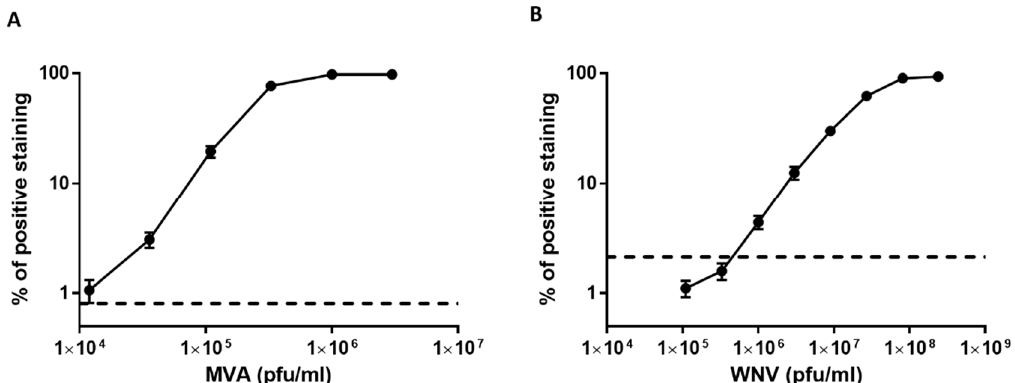
Figure 4. Dose response analysis of MVA and West Nile Virus after capture by Vero cells. ( A , B ) The cells were harvested and diluted to achieve 20,000 cells per tube. WNV and MVA (diluted in 2% FBS-MEM) were added at the indicated concentrations for one hour with shaking at 4 ◦ C to allow attachment. The cells were then immuno-labeled with a relevant fluorescent antibody and analyzed by FACS. Dashed black line represents the limit of detection of the assay (2.12% of positive staining for WNV and 0.8% for MVA) which was determined by 3 times the mean value of background noise from non-infected cells. The results shown represent average values ± SEM from 3 independent experiments in biological duplicates for each of the viruses.